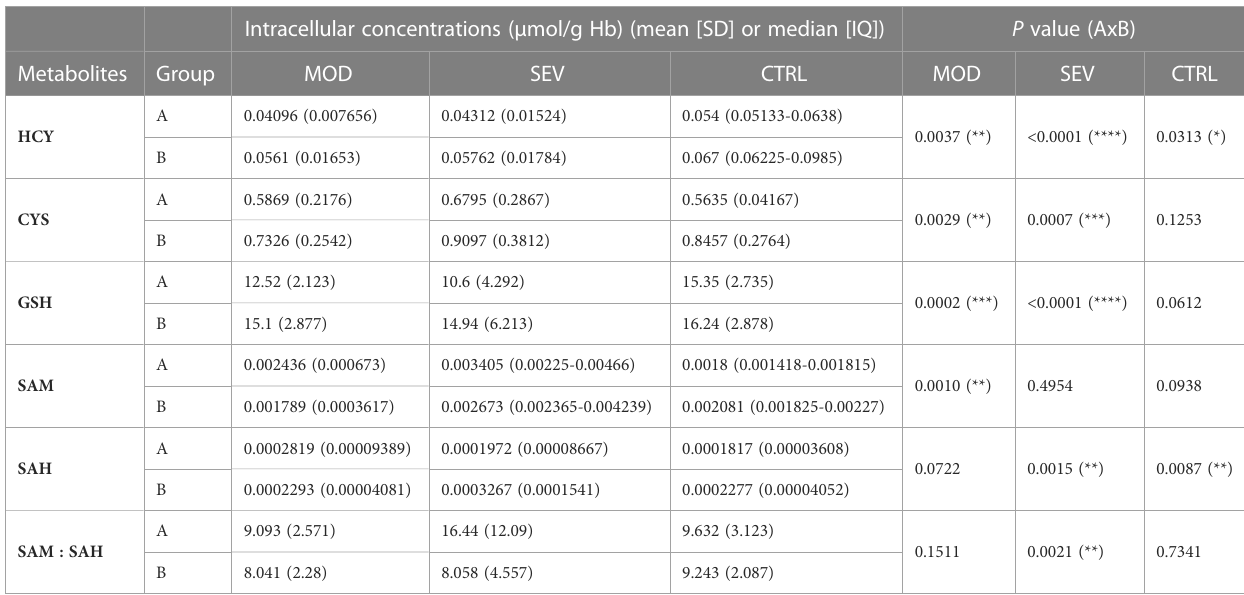
TABLE 2 Vitamin B12 increases the fl ow of the sulfur amino acid